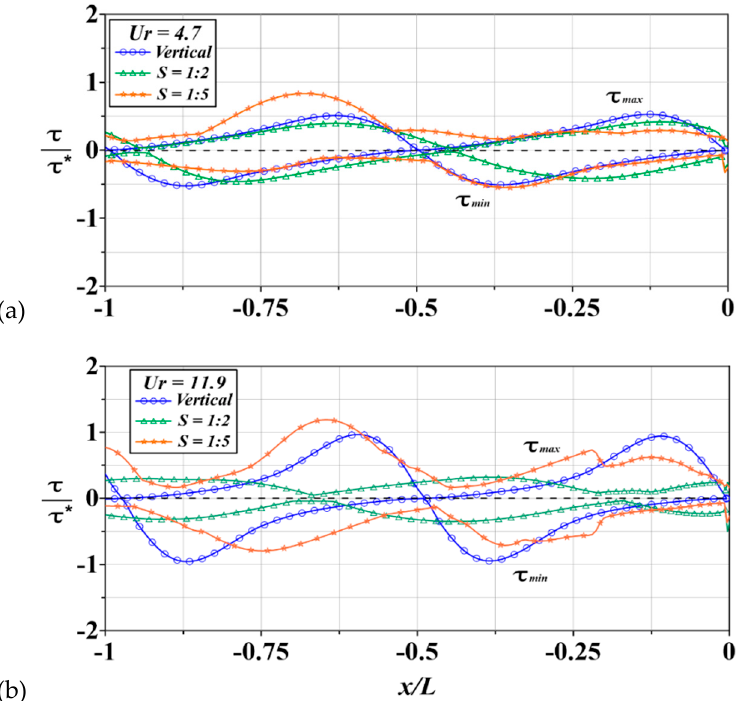
Figure 14. Comparison of the maximum bottom shear stress prior to the seawalls with different Ursell numbers: ( a ) 𝑈𝑟 = 4.7 and ( b ) 𝑈𝑟 = 11.9, respectively.